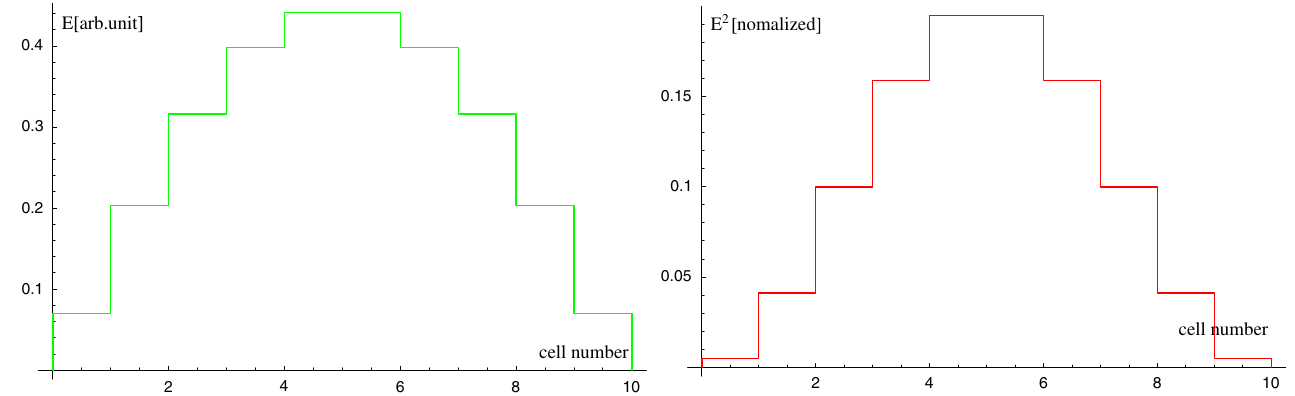
FIG. 13. (Color) Ten-cell cavity; left: field profile, right: field-square profile